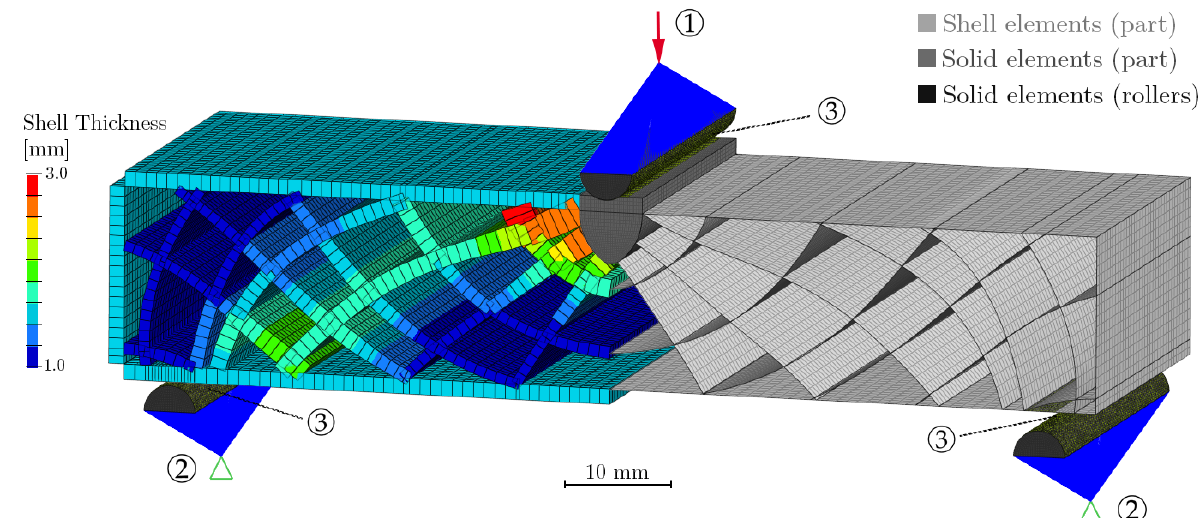
Figure 4. FE model in 2D shell representation ( right ), with indicated element thickness ( left ), multi-point constraints for load introduction 1 and supports 2 as well as contact surfaces 3 . For reference to colors, please refer to the online version of this